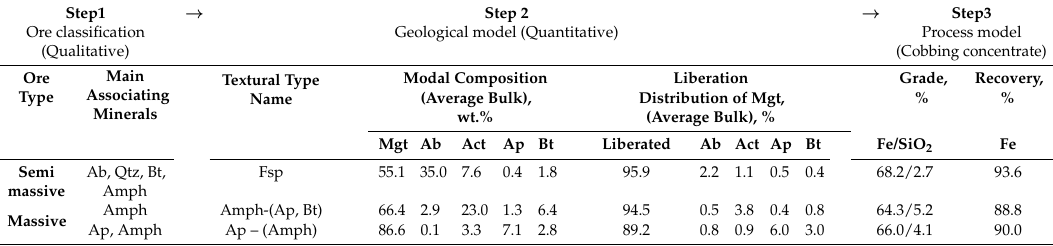
Table 3. The geometallurgical framework of how to simulate and forecast the metallurgical variation of ore deposit variables.